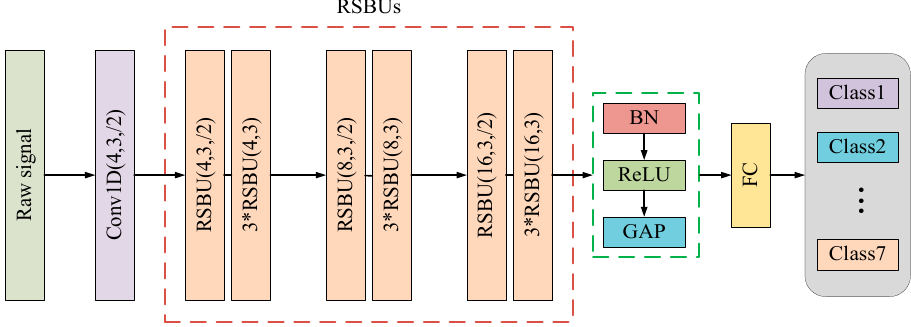
Figure 4. Structure of the proposed 1D DRSN.